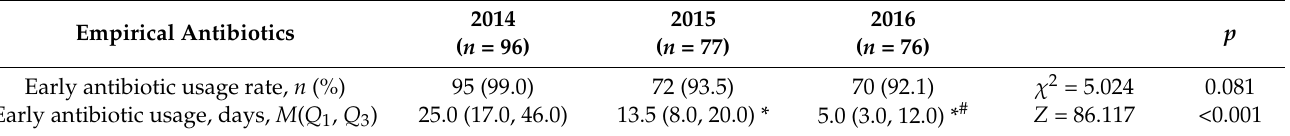
Table 2. Postnatal empirical antibiotic usage and short-term outcomes among the 3